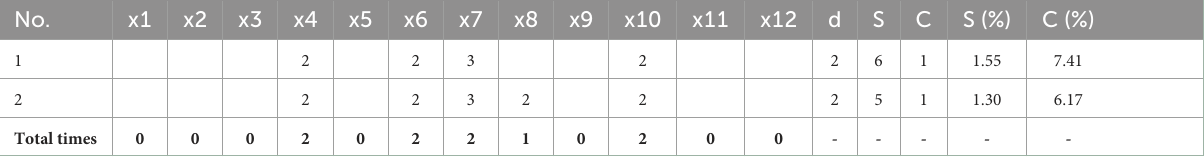
TABLE 7 Decision rules of medium intention to use GMFs with minimum support value ≥ 5. No.